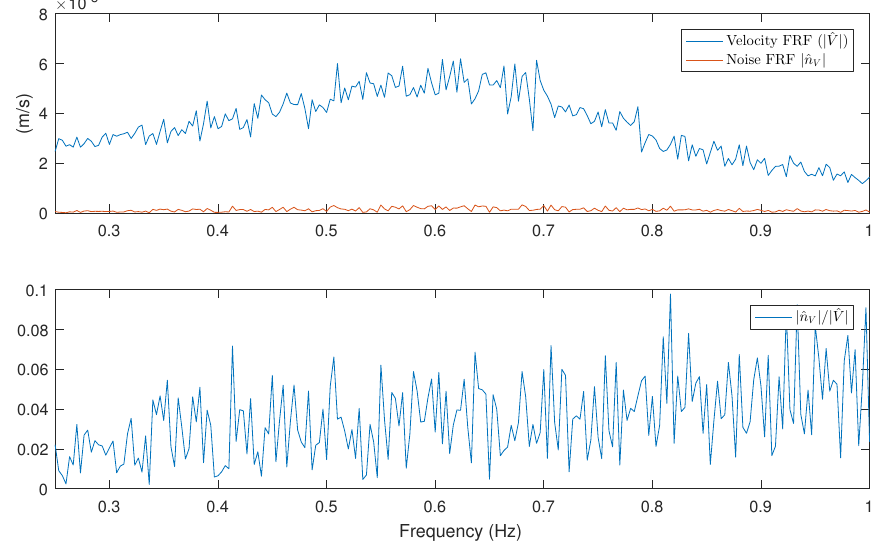
Figure 16. FRFs of the velocity ˆ V , of the estimated noise ˆ n V and of their ratio ˆ V /ˆ n V